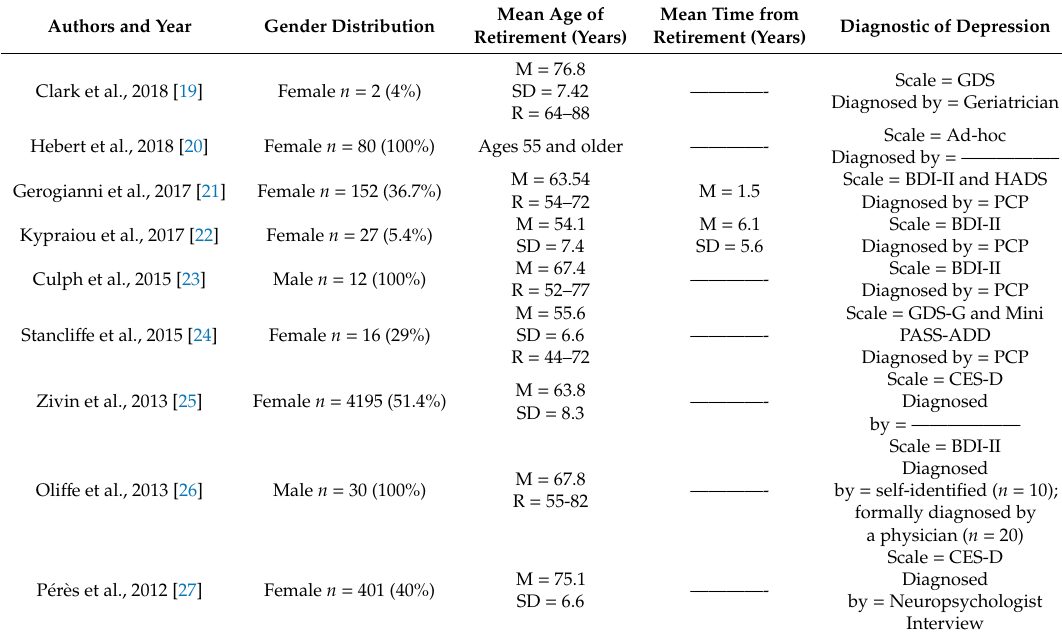
Table 2. Prevalence of depression in